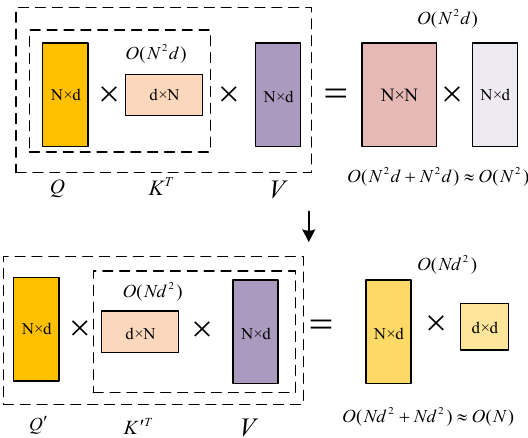
Figure 2. A brief analysis of time complexity.